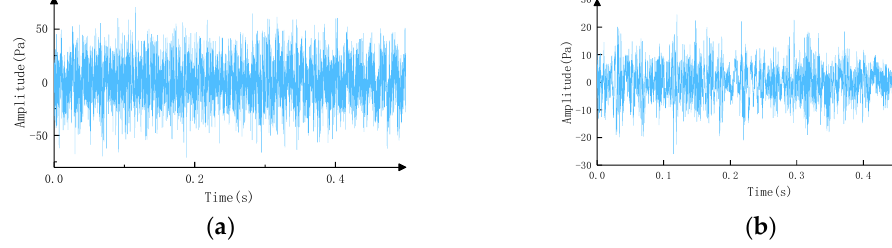
Figure 7. The waveform of ( a ) the first microphone original signal and ( b ) the fused signal.